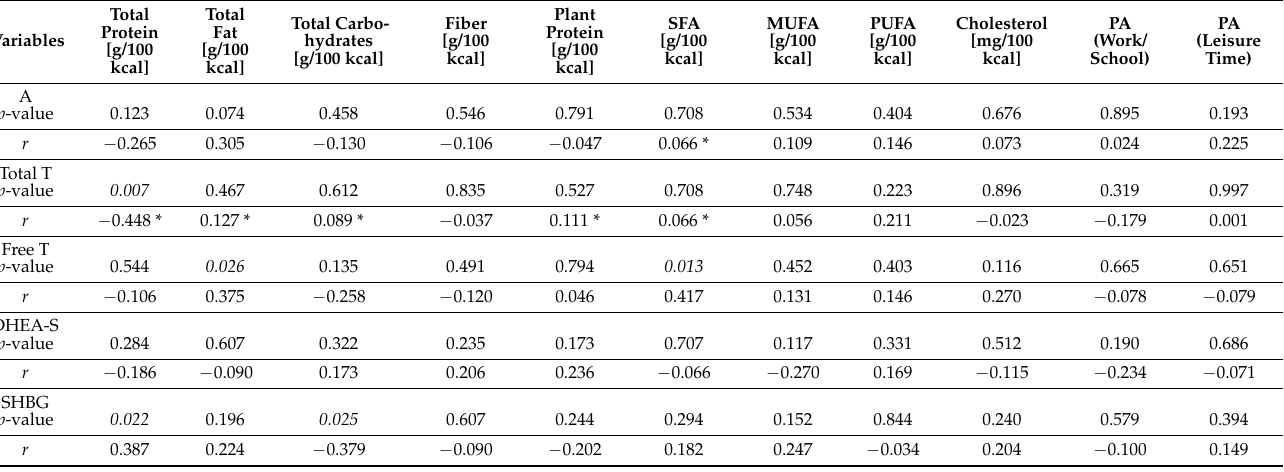
Table 4. Spearman and Pearson’s correlation coefficients among serum androgen level, and macronu- trient intake and PA. (CONTROL